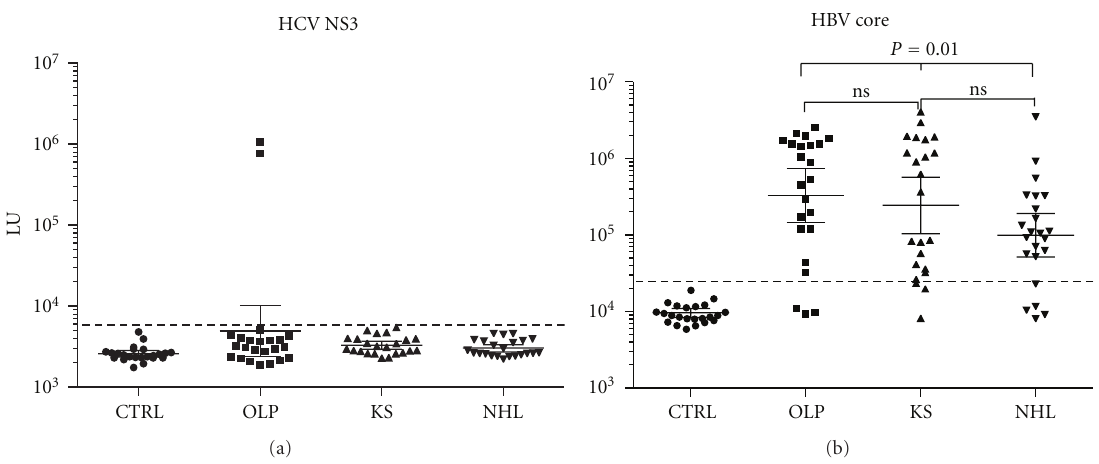
Figure 4: Anti-HCV and anti-HBV antibodies. (a) Antibody profiling against NS3 of HCV was plotted on the Y -axis using a log Only two patients were above the cut-o ff and HCV seropositive. (b) The anti-HBV antibody levels and 95% CI in the 23 control blood donors, 23 OLP, 23 KS, and 23 NHL subjects were plotted on the Y -axis using a log